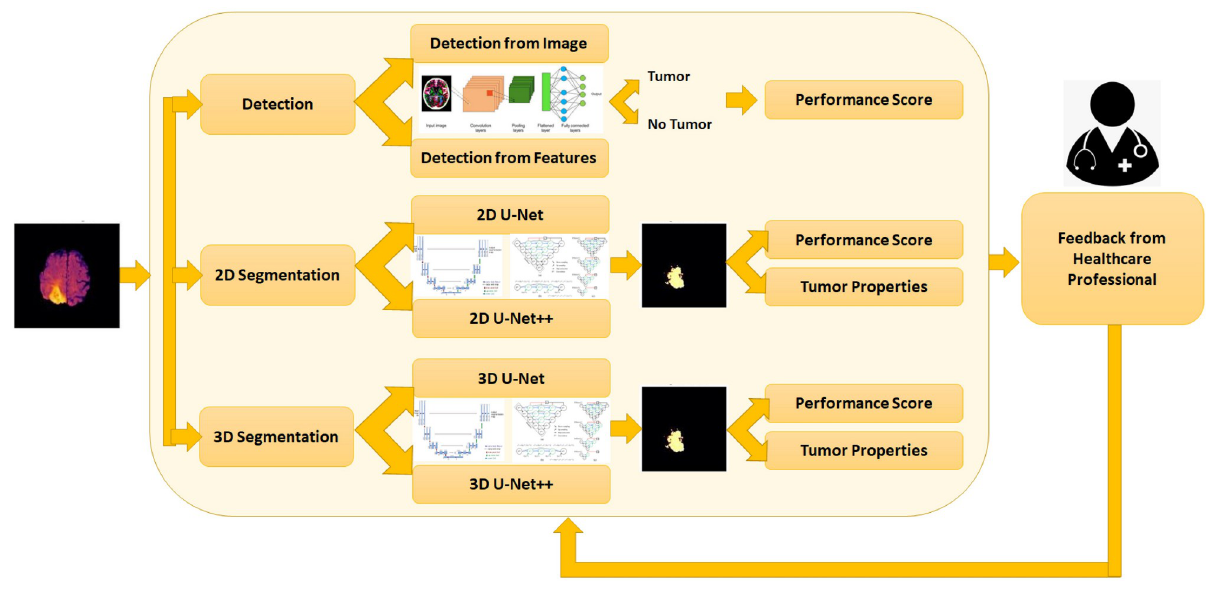
Fig 3. Overall framework for the proposed